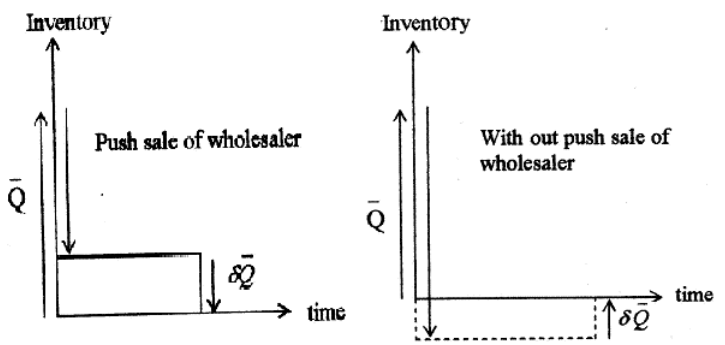
Figure 3. Wholesaler’s inventory/shortage